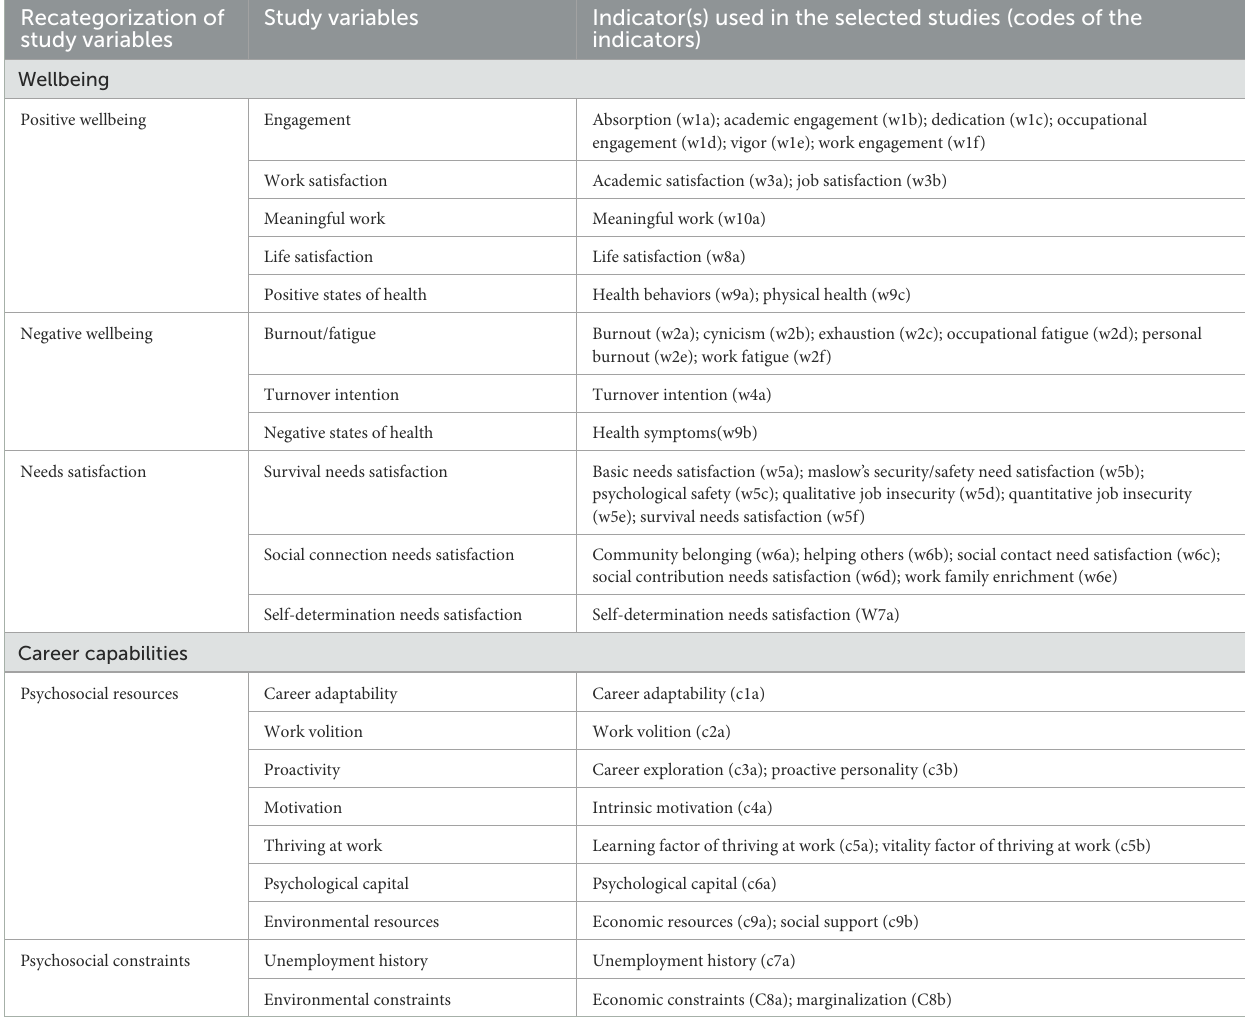
TABLE 2 Recategorization of study variables and indicators of wellbeing and career capabilities in the included studies. Recategorization of study